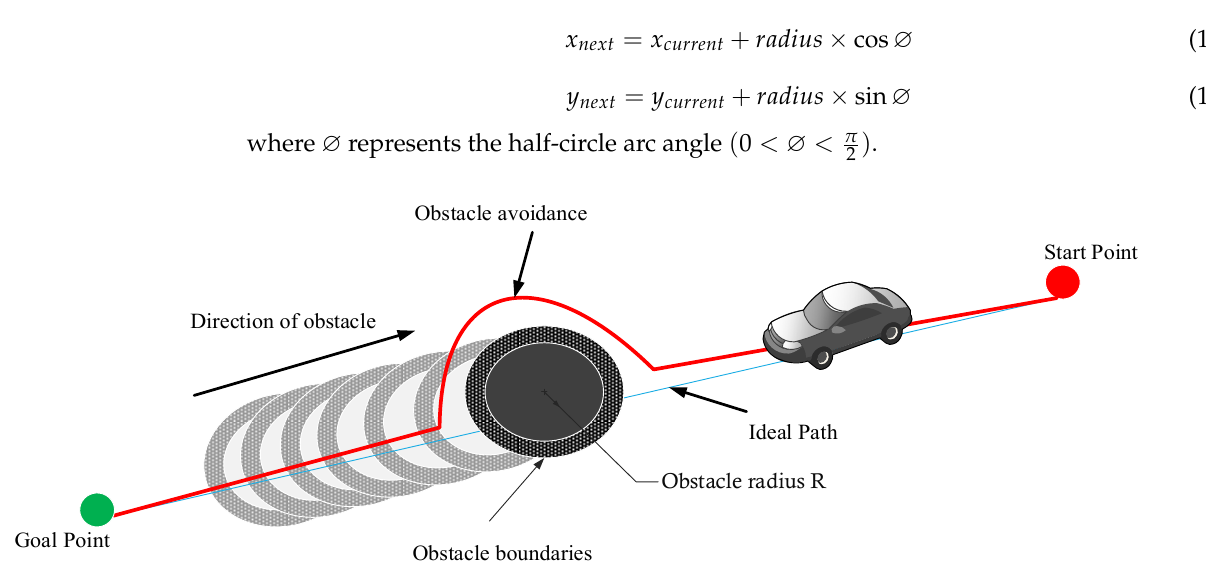
Figure 6. Dynamic obstacle collision avoidance.